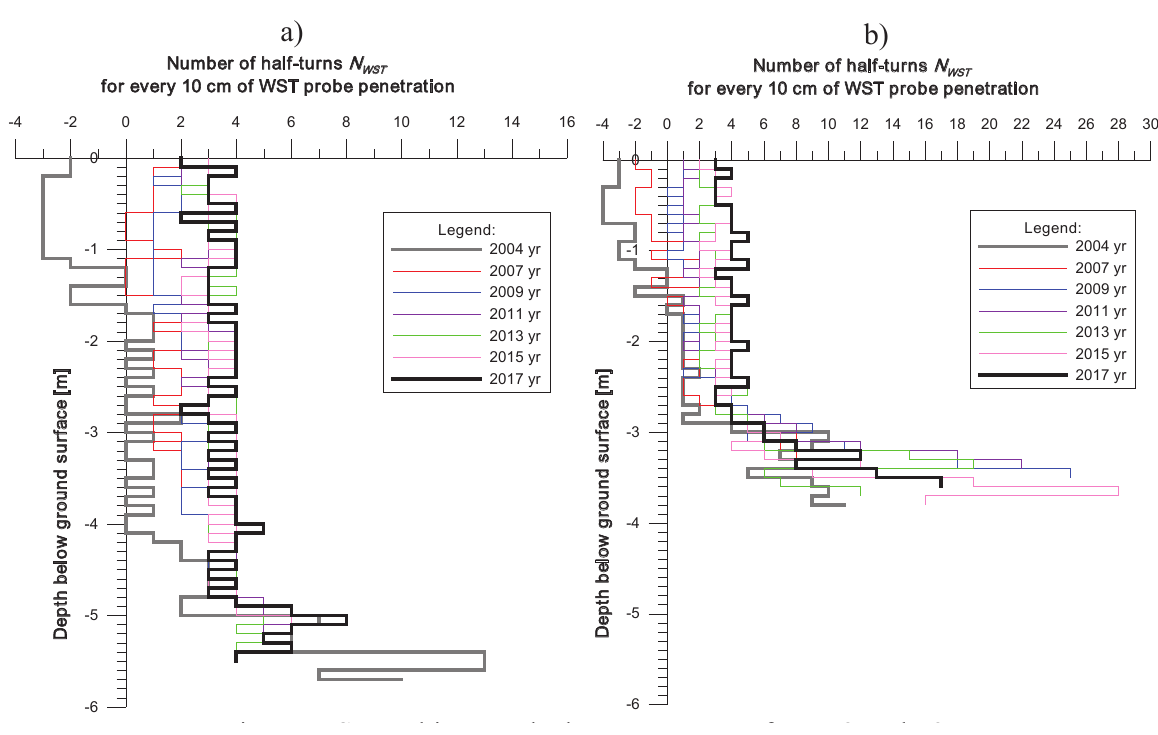
Fig. 5. WST probing results between counterforts P2 and P3 a) WST-3, b) WST-4 Figure 5 : WST probing results between counterforts P2 and P3: a) WST-3 and b) WST-4.